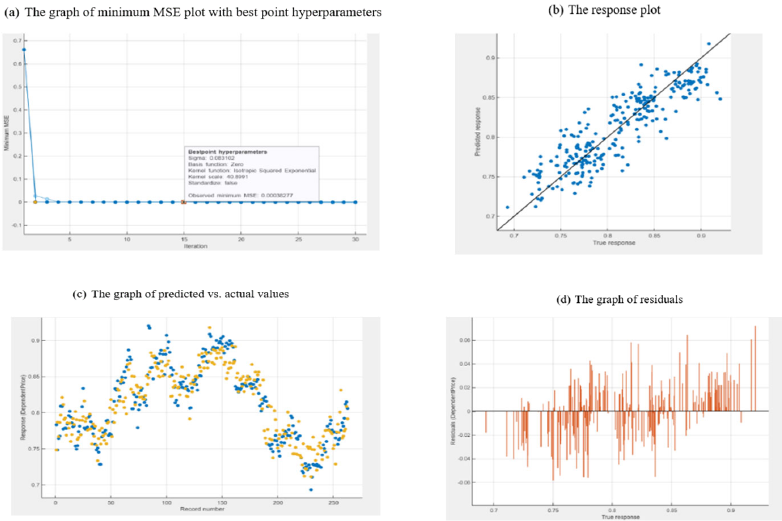
Fig. 9. Performance Graphs of Prediction Made with Gaussian Process Regression Method